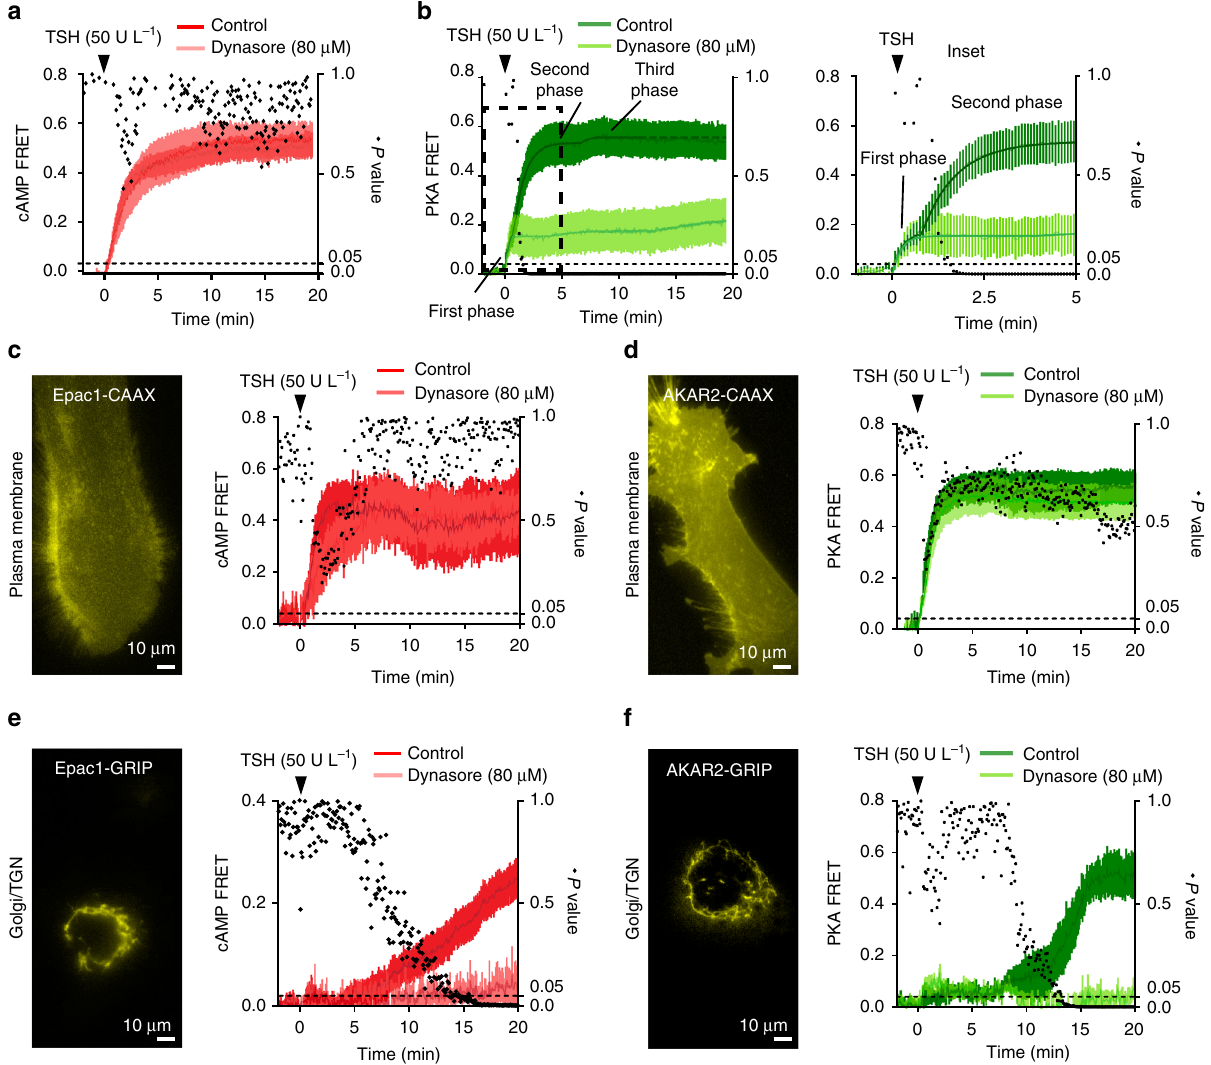
Fig. 5 TSHR internalization is associated with a late cAMP/PKA response at the Golgi/TGN. Primary thyroid cells isolated from Epac1-camps transgenic mice or from wild-type mice and transfected with various FRET-based sensors were used to monitor cAMP and PKA responses in real time. Cells were pretreated with or without (control) dynasore for 30 min, followed by TSH stimulation. Data were normalized to the basal value (set to 0) and the maximal response to forskolin at the end of each experiment (set to 1). Differences at individual time points were compared using the Holm- Š ídák test for multiple comparisons (black dots, P values). a cAMP FRET responses (mean ± s.e.m.; n = 8/10) in primary thyroid cells isolated from Epac1-camps mice. b PKA FRET responses (mean ± s.e.m.; n = 11/7) in primary thyroid cells transfected with the ubiquitous AKAR2 sensor. Data were fi tted with a three phase exponential model with delay (see Methods). c cAMP FRET responses (mean ± s.e.m.; n = 4/5) in primary thyroid cells transfected with the Epac1-camps sensor targeted to the plasma membrane (Epac1-CAAX). d PKA FRET responses (mean ± s.e.m.; n = 11/10) in primary thyroid cells transfected with the AKAR2 sensor targeted to the plasma membrane (AKAR2-CAAX). e cAMP FRET responses (mean ± s.e.m.; n = 8/4) in primary thyroid cells transfected with the Epac1-camps sensor targeted to the Golgi/TGN (Epac1-GRIP). f PKA FRET responses (mean ± s.e.m.; n = 5/4) in primary thyroid cells transfected with the AKAR2 sensor targeted to the Golgi/TGN